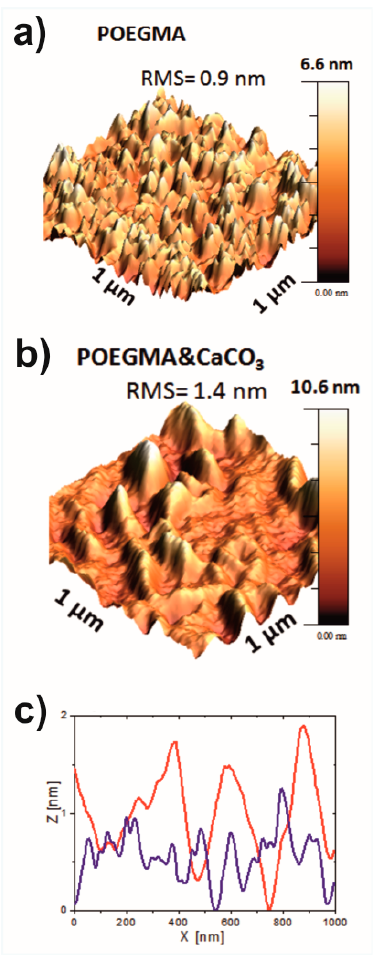
Figure 5. Images of the POEGMA-grafted brush ( a ) and POEGMA-grafted brushes with incorpo- rated CaCO 3 NPs ( b ) recorded using AFM working in topography ( a , b ) mode. Cross-line analysis corresponds to the topography ( c ) of the samples without (blue) and with CaCO 3 NPs